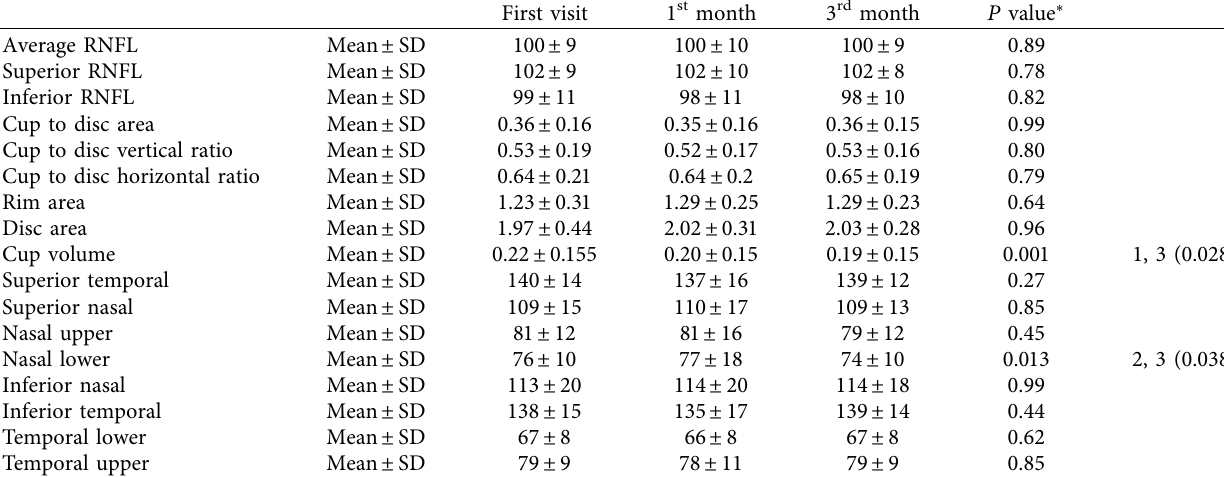
Table 1: Peripapillary optical coherence tomography parameters over the study